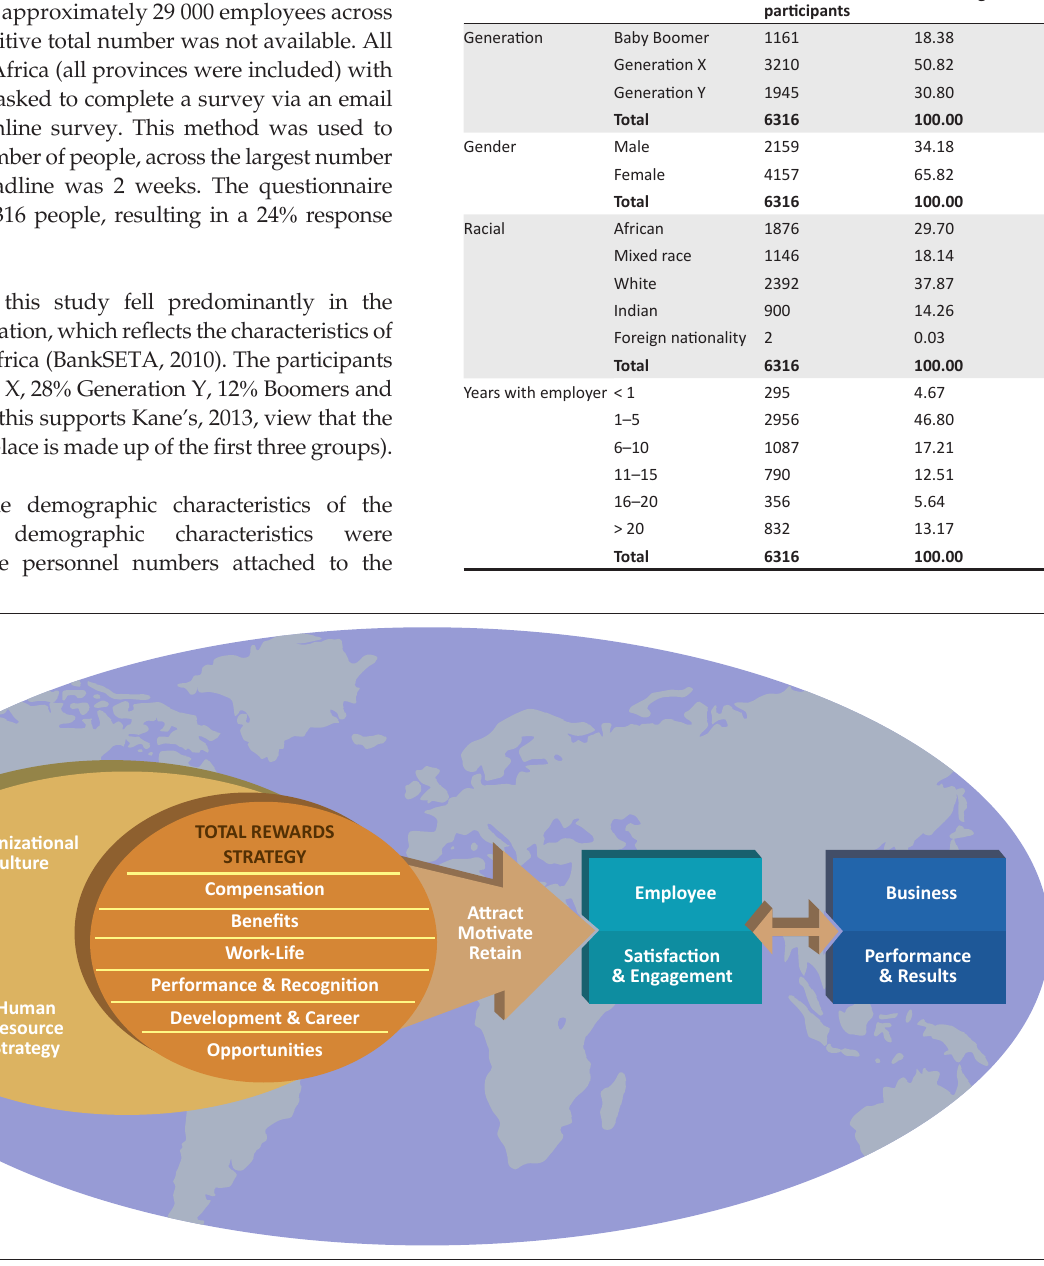
FIGURE 1: WorldatWork (2006) total reward strategy